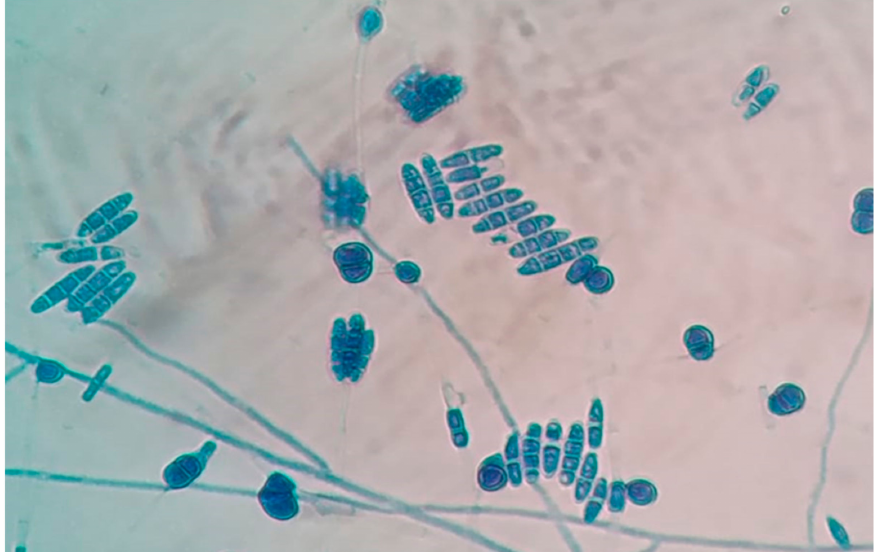
Figure 4. Lactophenol cotton blue mount of Fusarium lichenicola showing 2–4 celled macroconidia and multi-celled chlamydospores (Magnification: 40 ×